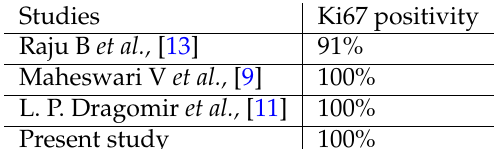
Table 8. Ki67 positivity with other studies